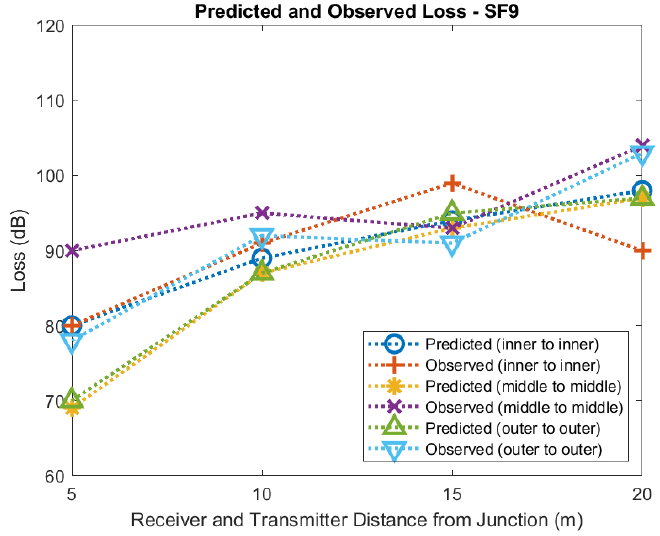
Figure 22. Diffraction modelling of predicted and observed loss at tunnel junction